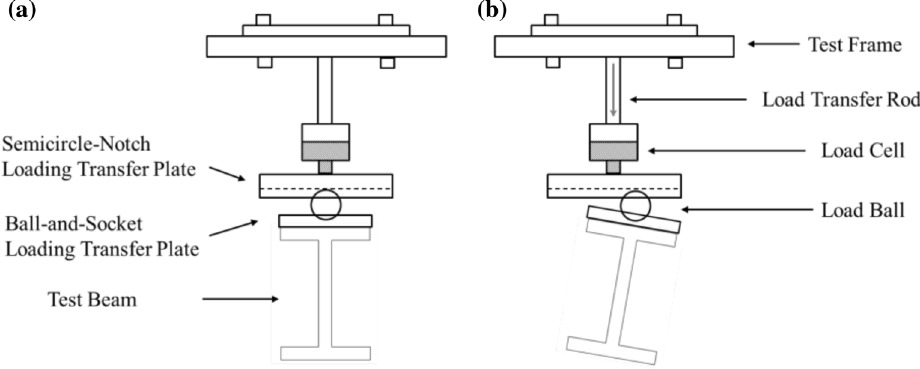
Fig. 3 Design of the loading system for the a undeflected and b deflected configurations of a beam.